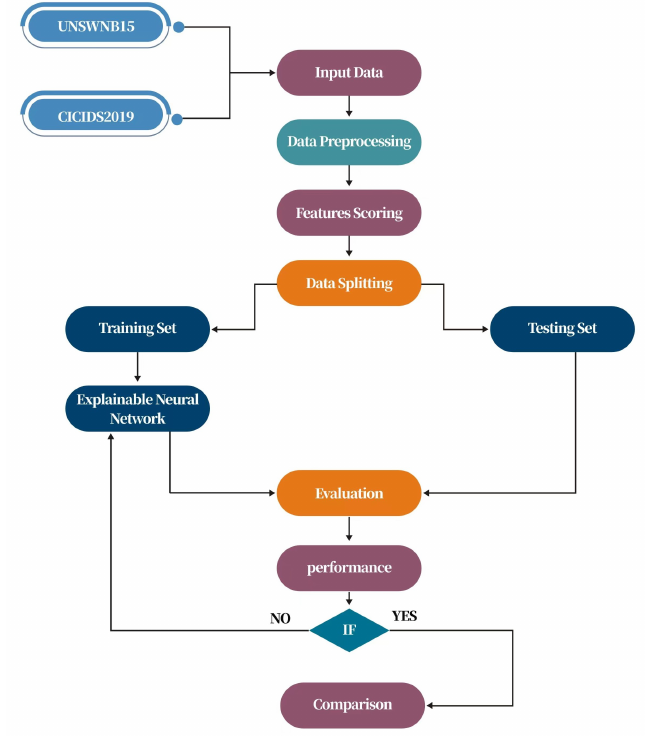
Figure 4. The proposed